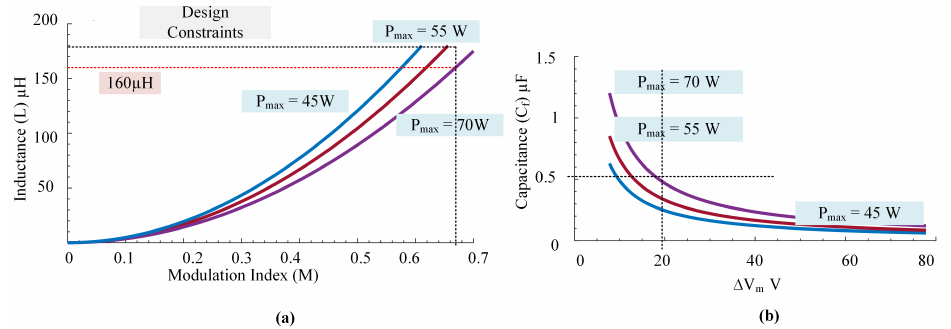
Figure 6. ( a ) Inductance value vs. modulation index. ( b ) (cid:52) V m versus capacitance value for various power